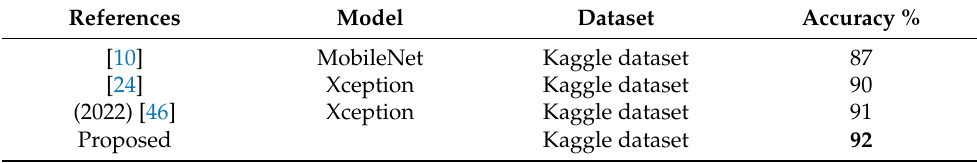
Table 10. Significant results of ASD diagnosis system against existing diagnosis